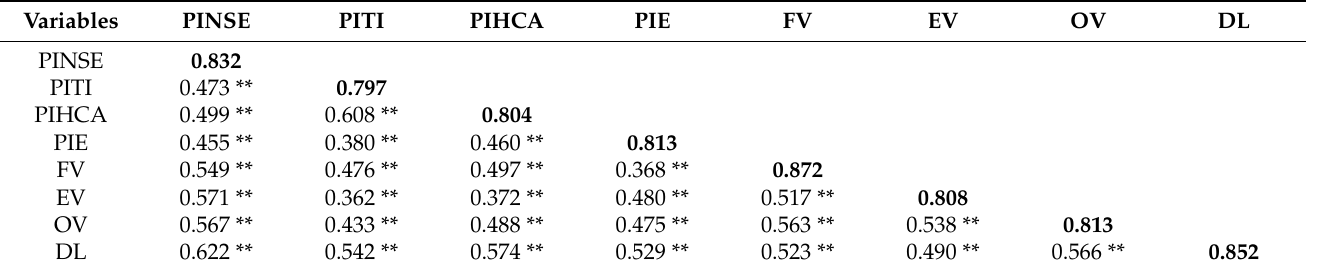
Table 3. Discriminant